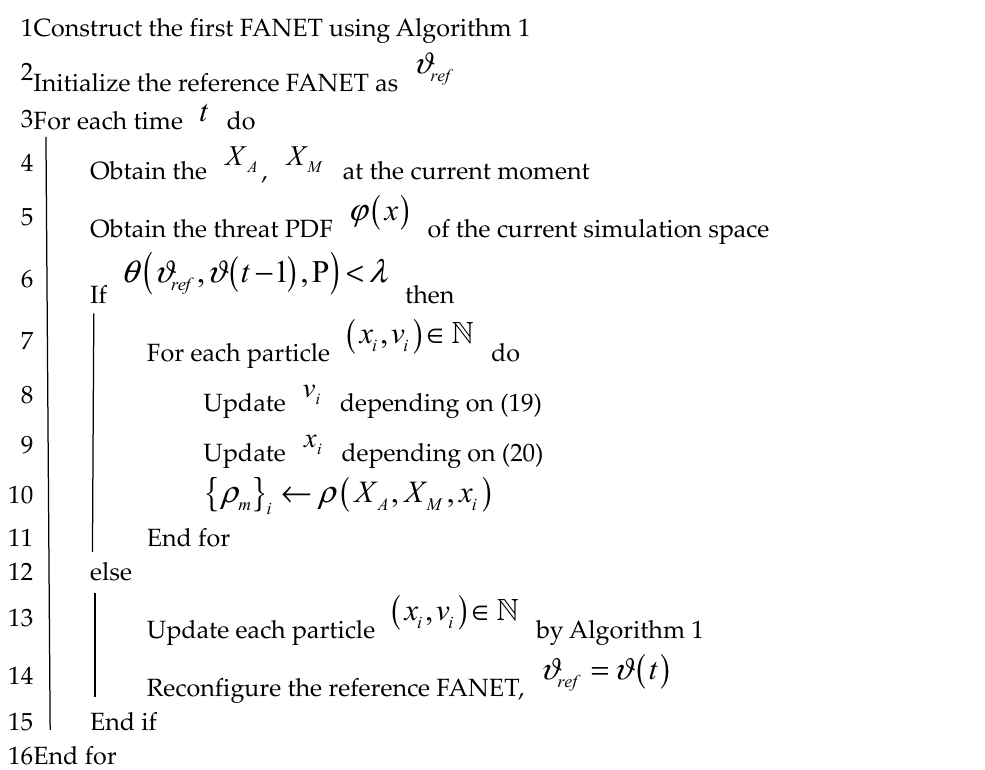
Algorithm 2 Dynamic Threat Avoidance and Continuous Reconnaissance FANET Oper- Algorithm 2. Dynamic Threat Avoidance and Continuous Reconnaissance FANET Operation